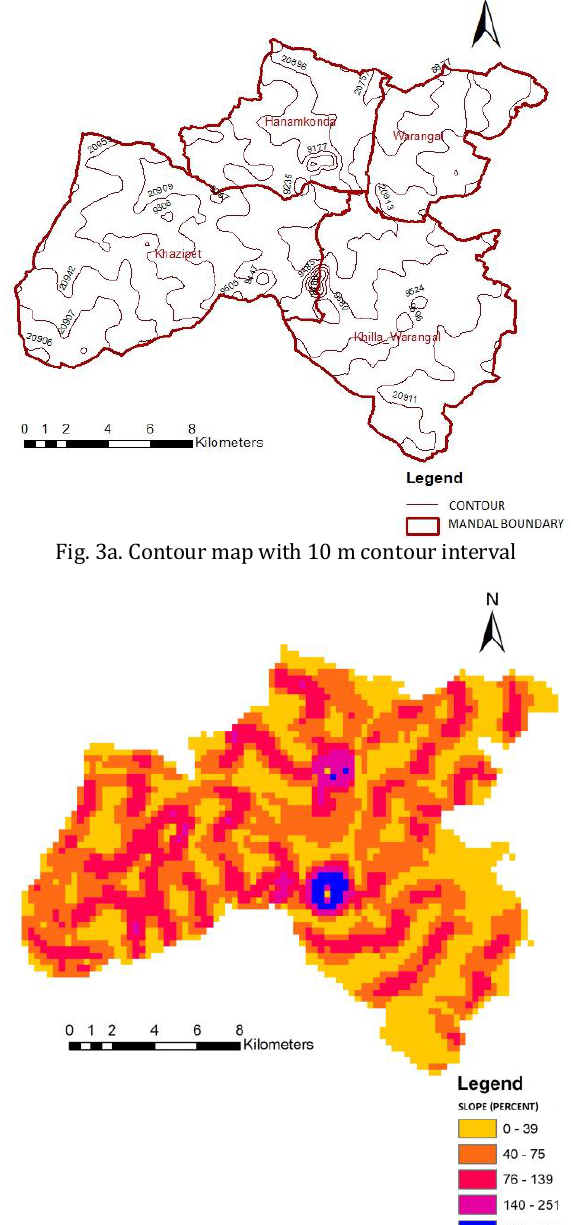
Fig. 3b. DEM extracted from contour map Fig. 3c. Slope map showing the percentage of